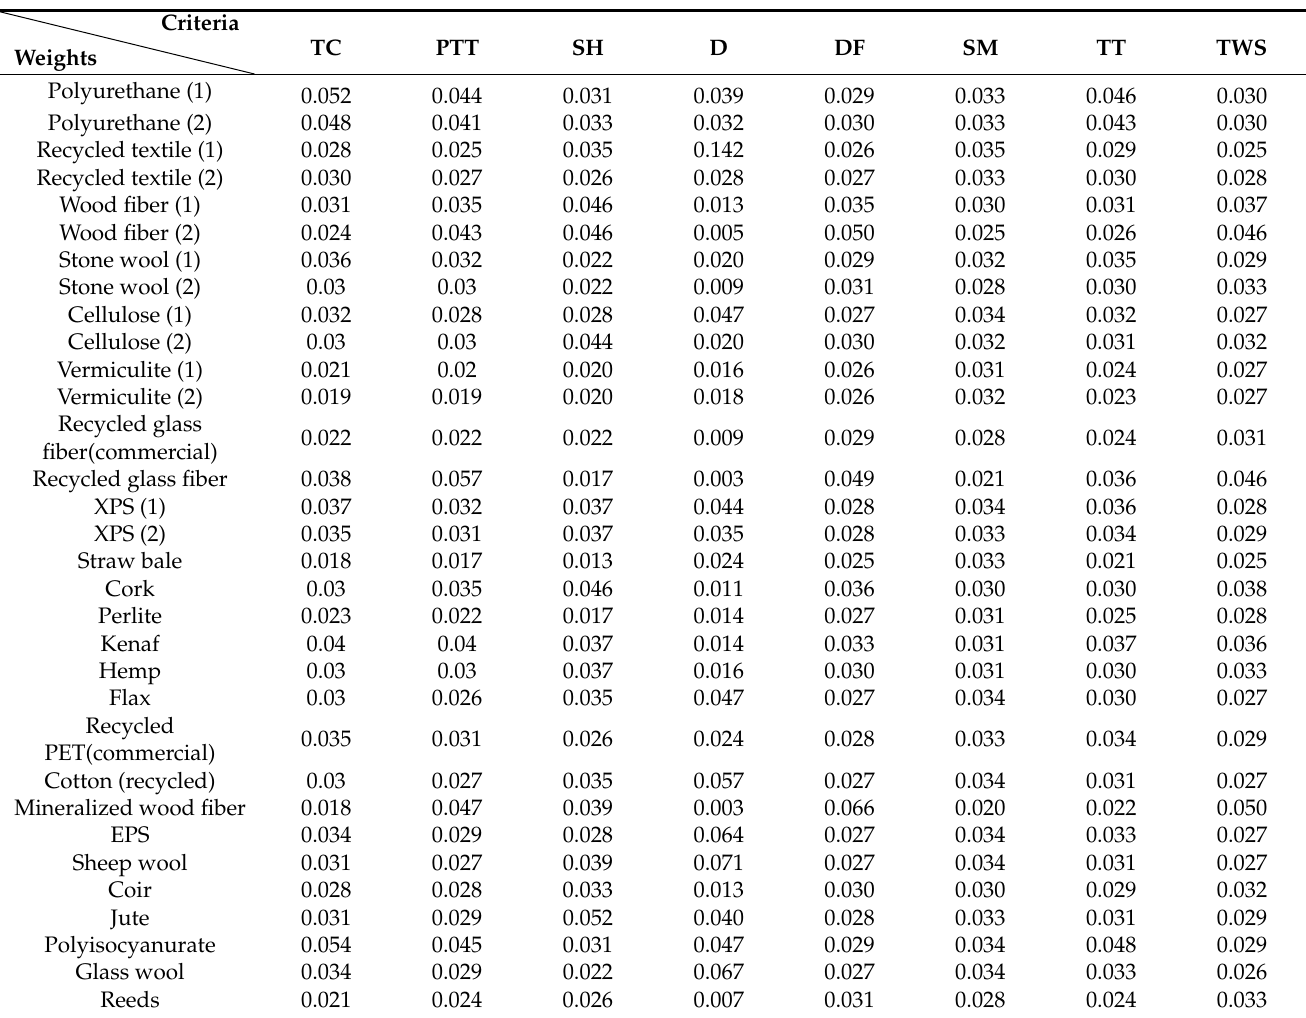
Table 7. The results of Normalization Procedure 1.